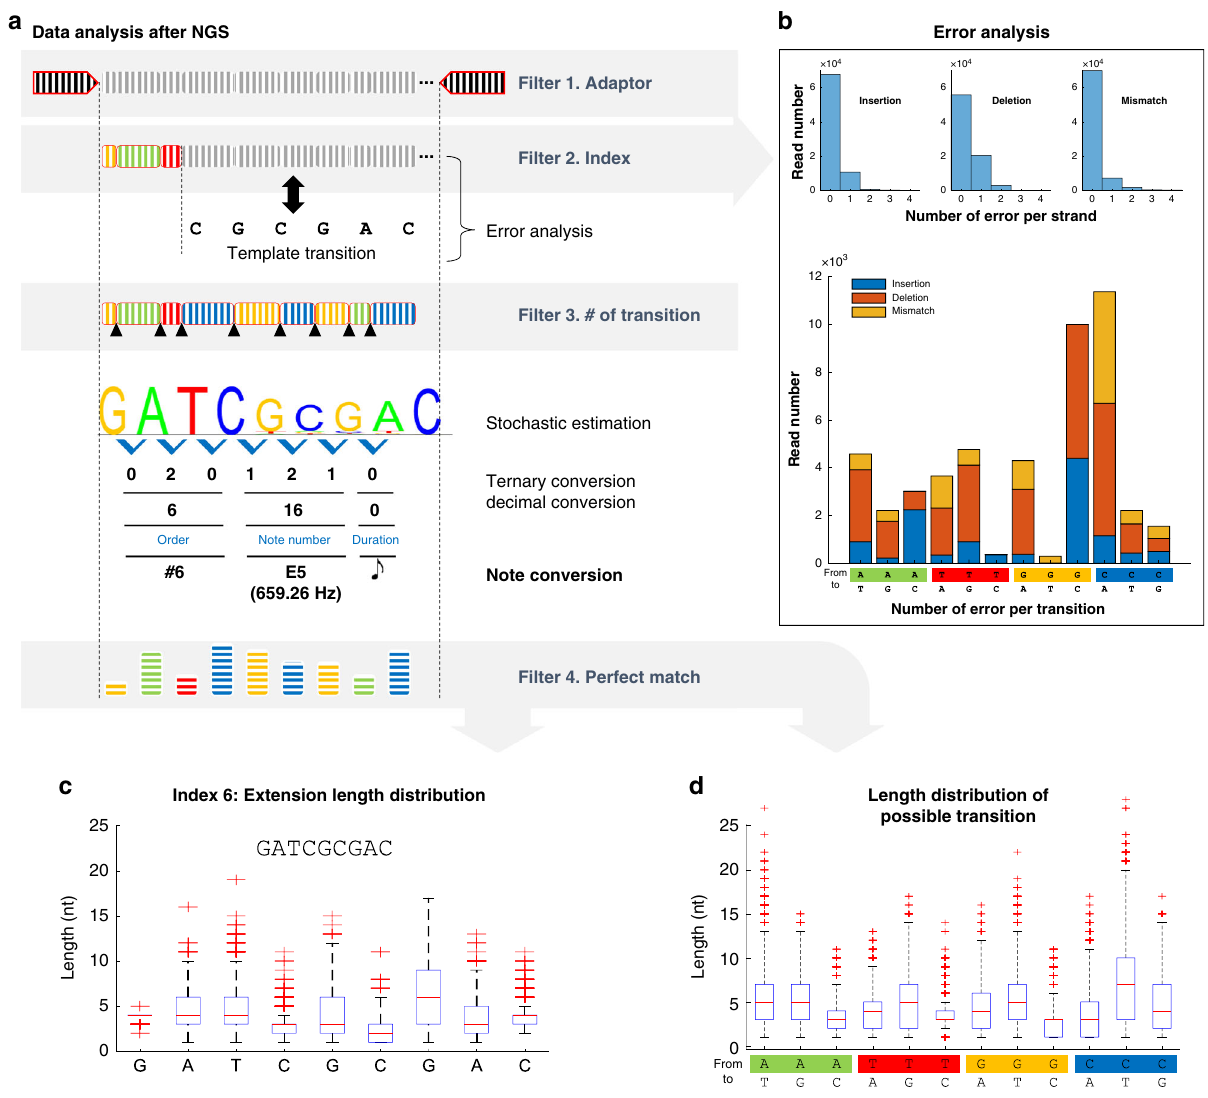
Fig. 5 Demonstration of digital music data storage in DNA oligonucleotides enzymatically synthesized in multiplex: decoding and data analysis. a During the decoding process, several fi lters are applied to extract and align the reads that contain the digital music data to the expected template sequences. Template alignment was performed using the Smith – Waterman algorithm. b From this, error analysis can be performed to determine the quality of multiplex synthesis. The upper histogram indicates the percentage of insertions, deletions, or mismatches that occurred in the fi ltered sequencing reads. The bottom histogram indicates the number of reads containing errors for each possible base transition across the array. c Sequencing data also yields statistical information regarding the extension length distribution for each base transition for all 12 oligonucleotides synthesized in multiplex. For example, subset 6, which indicates sequence index 6 is shown in the box plot. All other subsets are indicated in Supplementary Figs. 10 and 11 . d Additional statistics such as the extension length distribution for all possible transitions from the entire array were analyzed as shown in the indicated box plot with red pluses being statistical outliers. Source data are provided as a Source Data fi